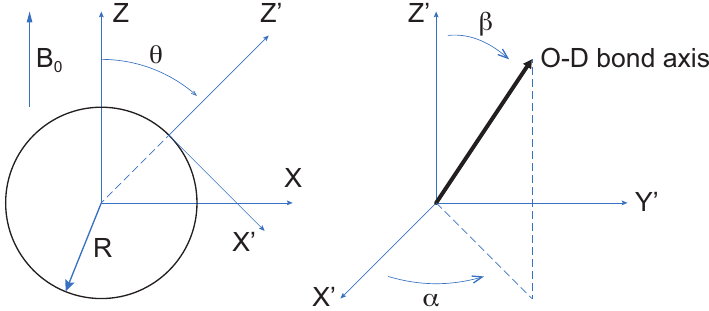
Figure 2. Definition of the angles θ , α and β appearing in Equation (7). (X, Y, Z) refers to the laboratory frame. (X’, Y’, Z’) is the frame associated with the water molecule diffusing in the cylindrical cavity surface. R is the cylinder radius. Due to the sample preparation method, the static magnetic field B 0 of the spectrometer is expected to be, on average, orthogonal to the cylinders’ axis. ( t ) were evaluated as follows The correlation functions X ( τ ) ≡ V 2, k ( t − τ ) V ∗ 2, k